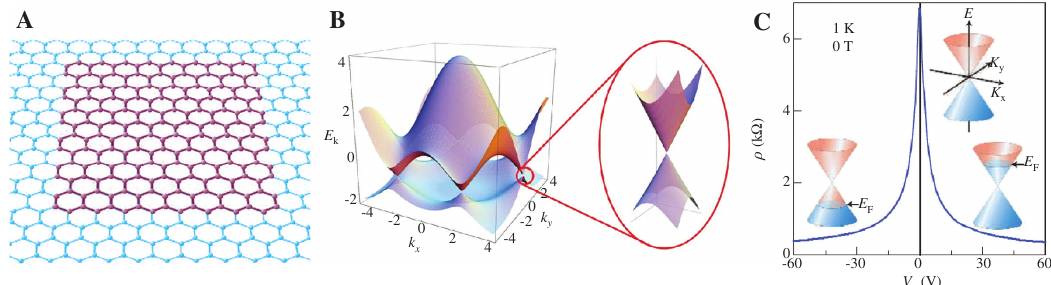
Figure 11: (A) Hexagonal honenycomb lattice of graphene (Reprinted by permission from Macmillan Publishers Ltd: Nat. Mater [80], copyright (2007)). (B) Electronic band structure of graphene. Right: zoom in of the energy bands close to one of the Dirac points (from [81], http://dx.doi.org/10.1103/RevModPhys.81.109). (C) Electric field effect on resistivity in single-layer graphene. The insets show its conical low-energy spectrum E(k), indicating changes in the position of the Fermi energy E